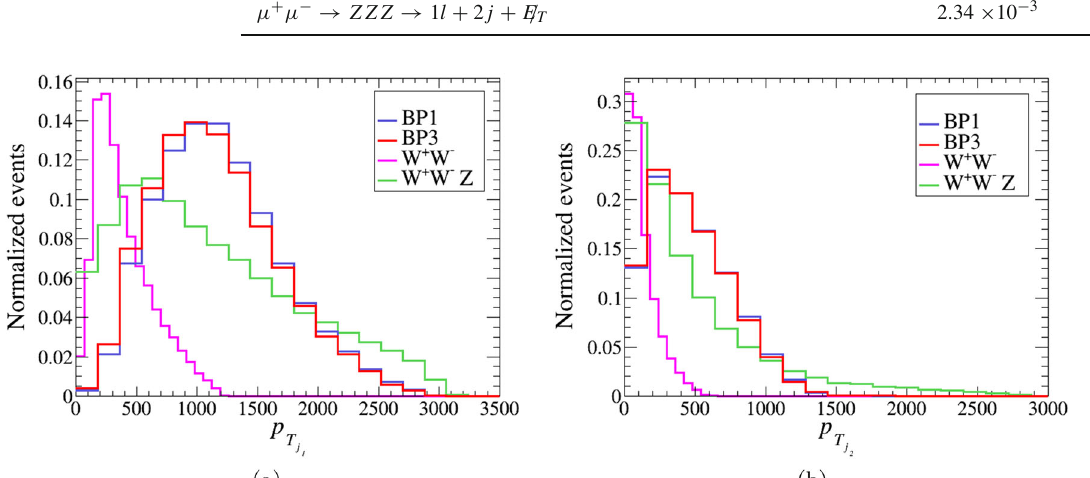
, b p T (for signal and SM background) for 1 l + 2 j + E T / channel at 6 TeV j 1 j 2